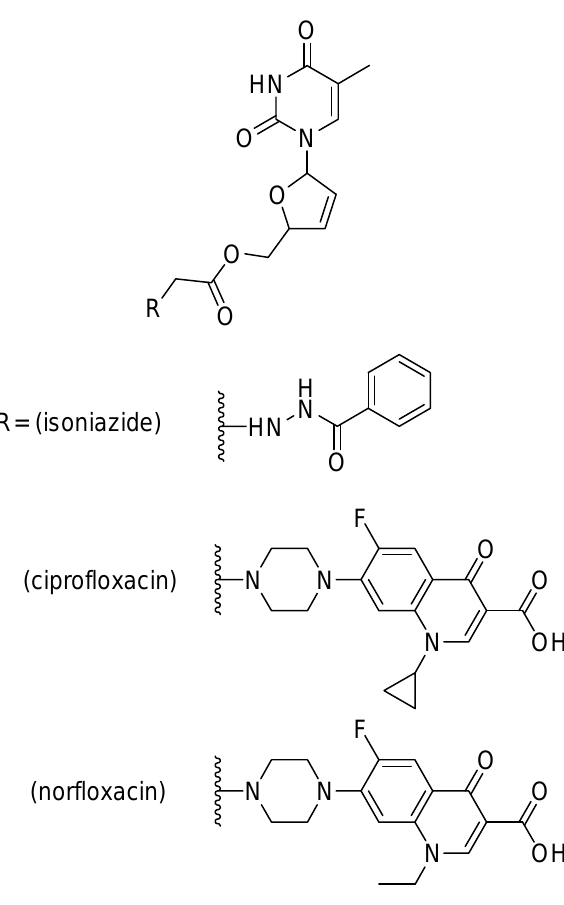
Figure 38. Ester prodrugs of stavudine.